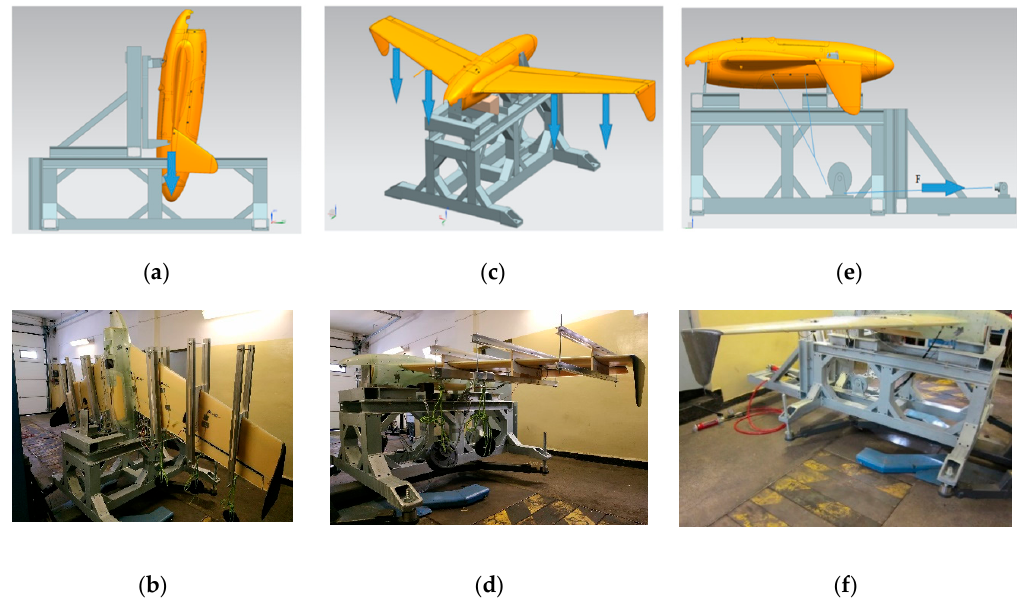
Figure 13. Test rig and RPAS configuration for all stages of static test ( a ) take-off (model) ( b ) take-off (execution) ( c ) flight (model) ( d ) flight (execution) ( e ) parachute release (model) ( f ) parachute release (execution).